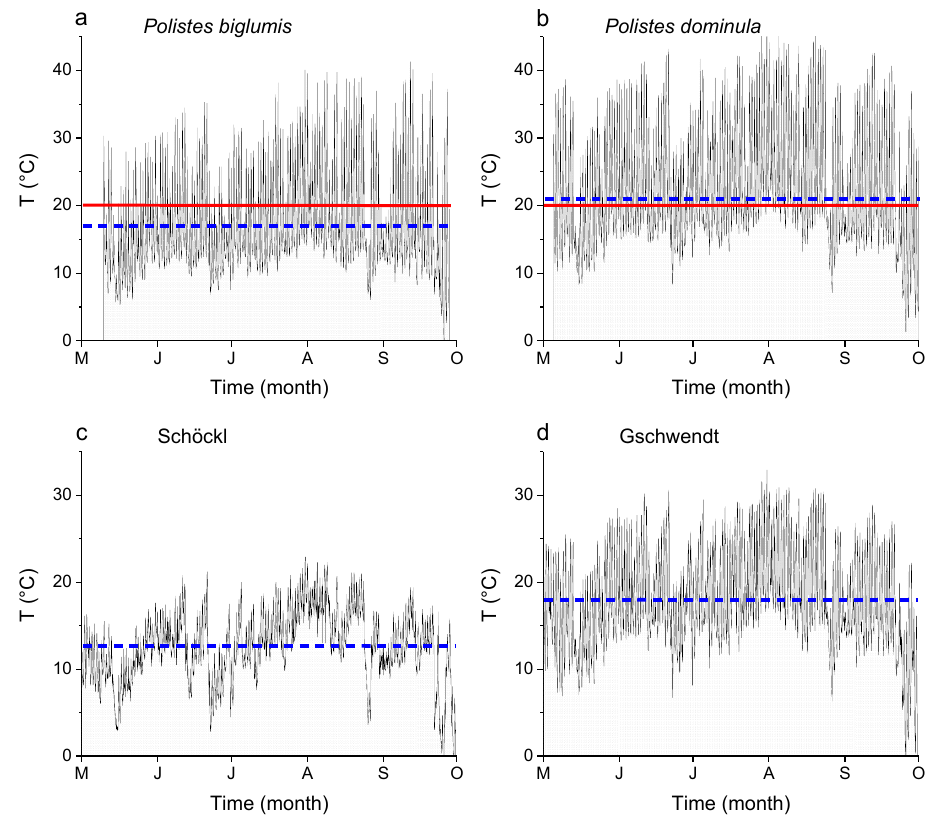
Figure 3. Temperature recordings of the microclimate at a nest of ( a ) Polistes biglumis and ( b ) Polistes dominula , and standard recordings of the ambient temperature at the nearest weather station to the Polistes biglumis nest at ( c ) Schöckl (47 ◦ 11 (cid:48) 53.25” N, 15 ◦ 27 (cid:48) 56.18” E; 1445 m ASL) and to the Polistes dominula nest at ( d ) Gschwendt (47 ◦ 10 (cid:48) 41.62” N, 15 ◦ 34 (cid:48) 22.52” E; 522 m ASL). The blue line (dashed) indicates the mean of the recorded period from May to October 2018, and the red line (solid) marks the threshold of onset of foraging